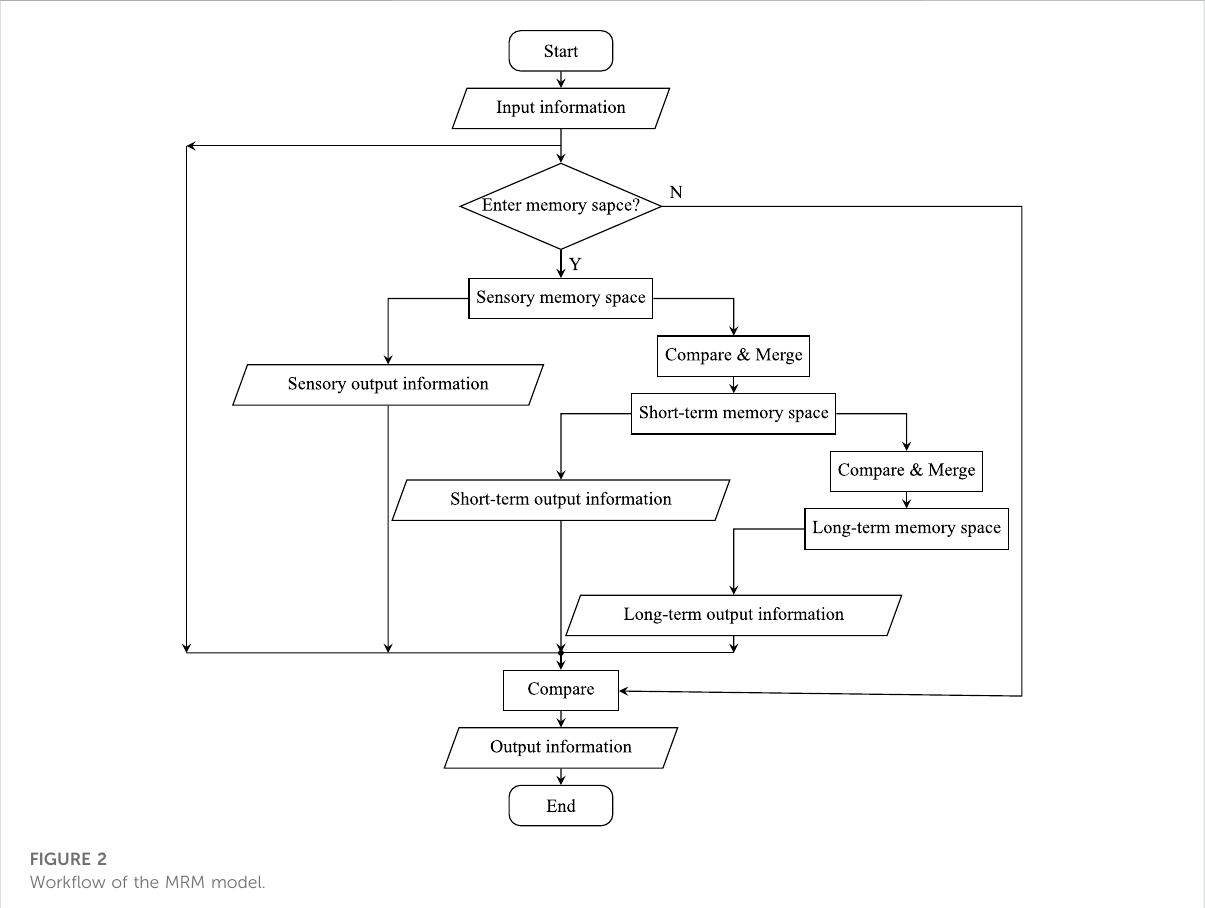
FIGURE 2 Work fl ow of the MRM